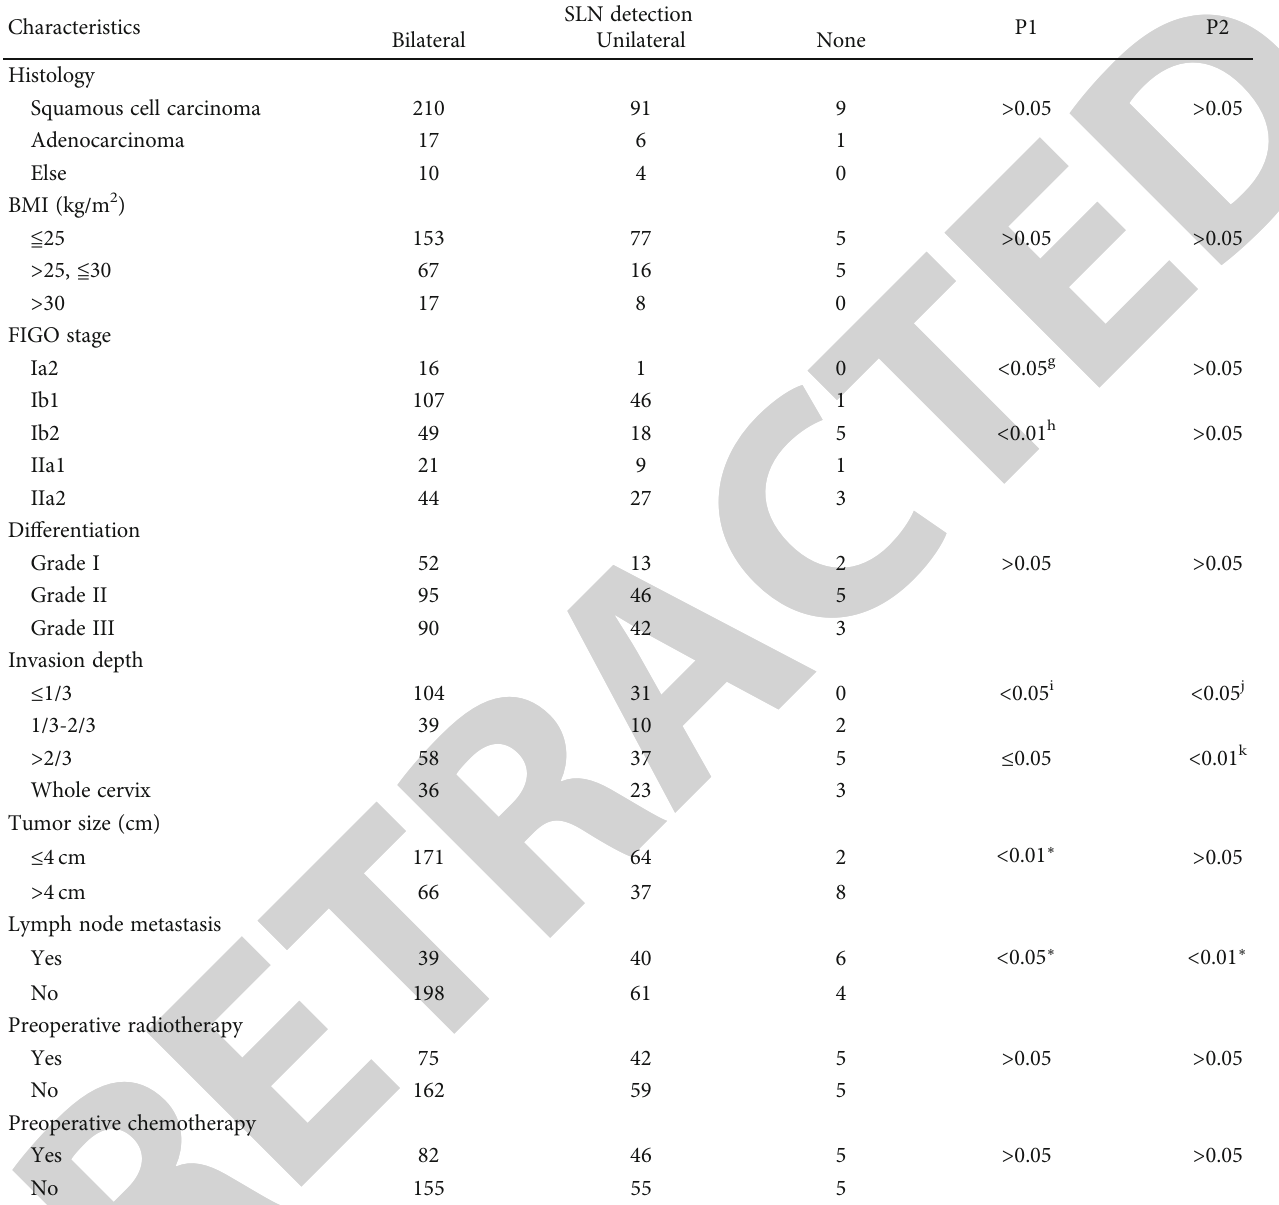
Table 3: Relationship between clinical characteristics and SLN